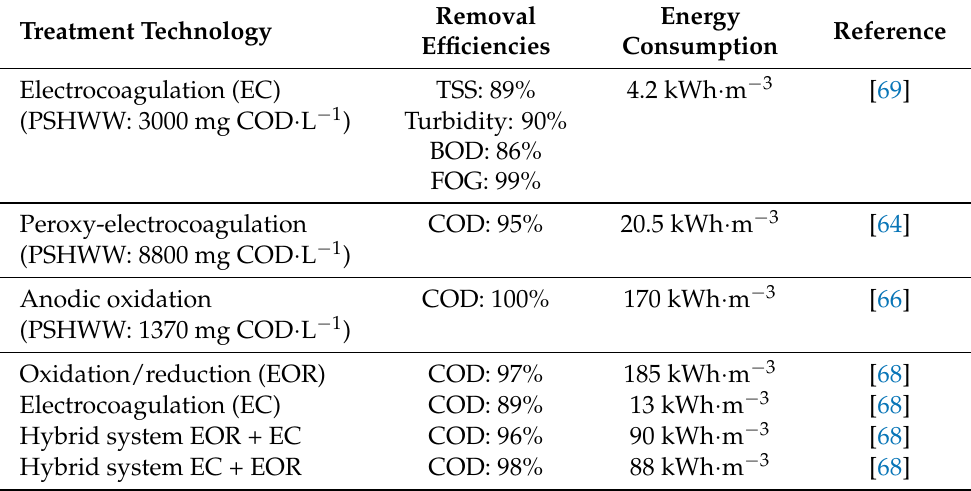
Table 5. Treatment of SWW with electrochemical